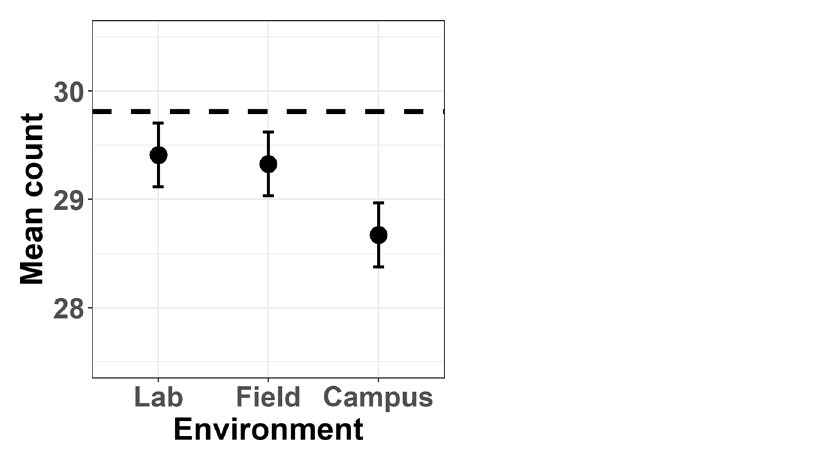
Figure 2. Estimated marginal mean counts of deviant stimuli per block across environmental conditions (Lab, Field, Campus). Error bars indicate 84% confidence intervals. Dashed line indicates perfect